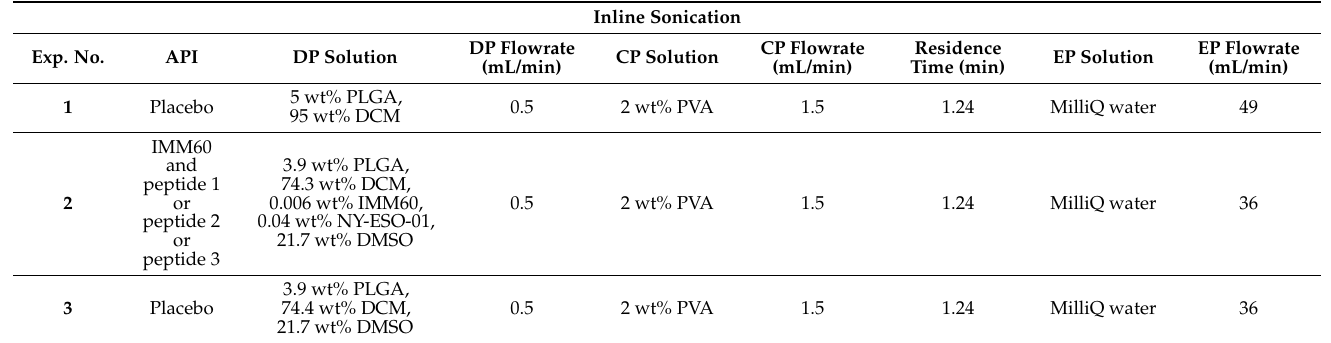
Table 2. Process parameters used for the formulation assessment and the production of immunomod- ulating nanovaccines with the scale-up inline sonication method. Inline